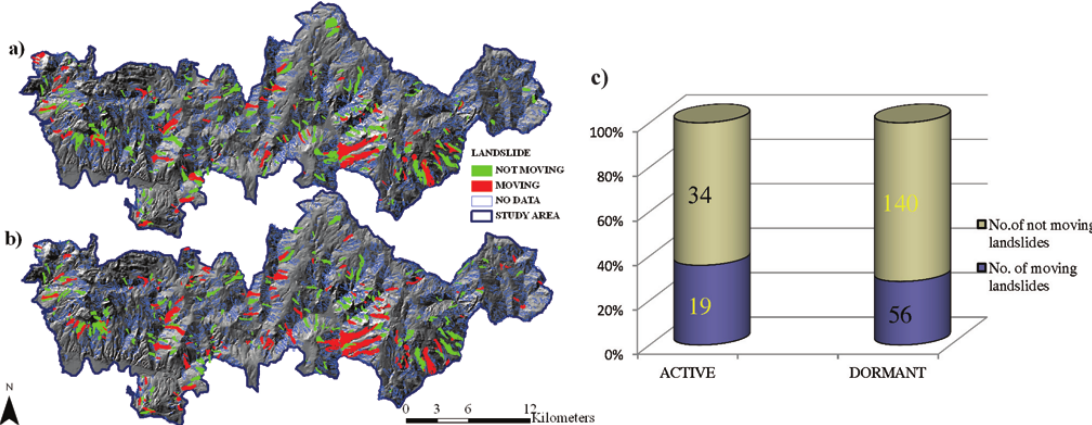
Fig. 16. Map of moving/not moving landslide according to both ERS (a) and ENVISAT PSI (b) data; (c) comparison among the state of activity derived from either the landslide inventory map or the indication of movement derived from ERS-PSI